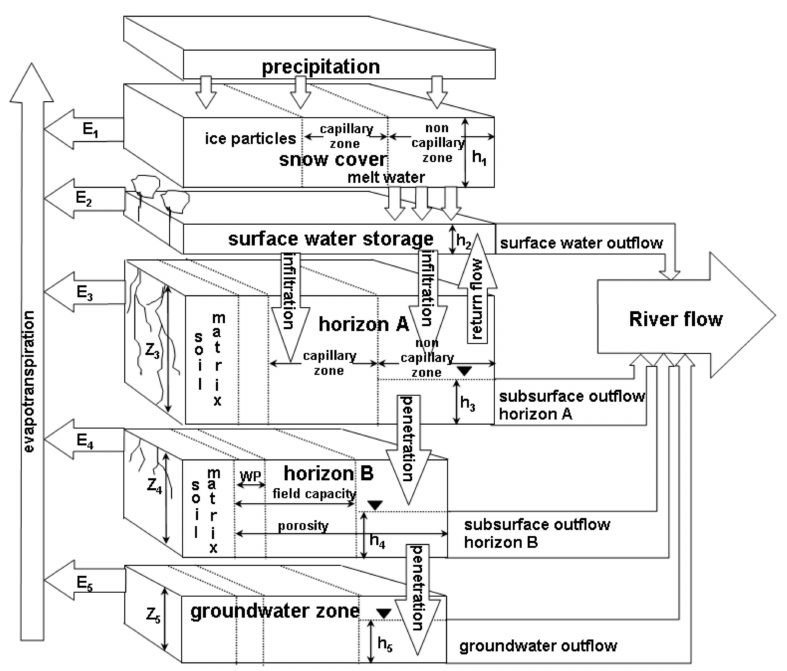
Figure 1. Schematic representation of water pathways in ECOMAG elementary